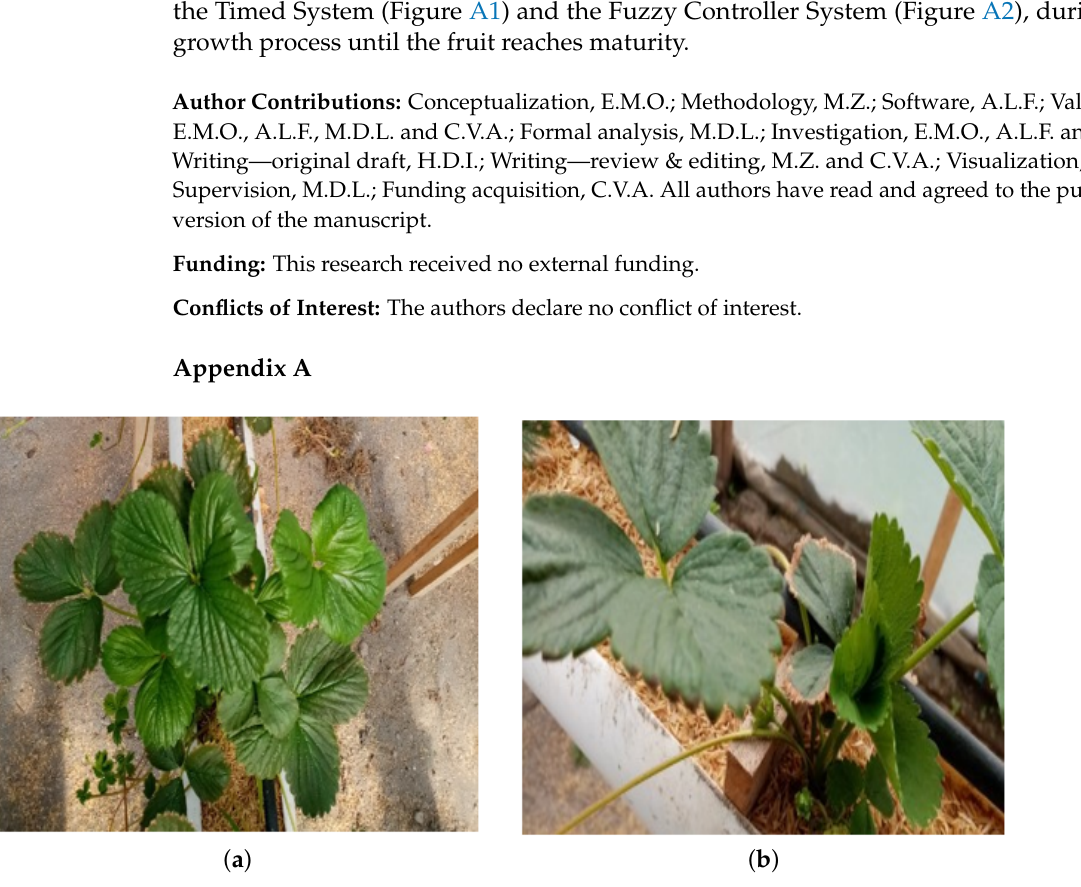
Figure A1. ( a ) Cultivation with fuzzy control irrigation system. ( b ) Cultivation with timed irrigation system.